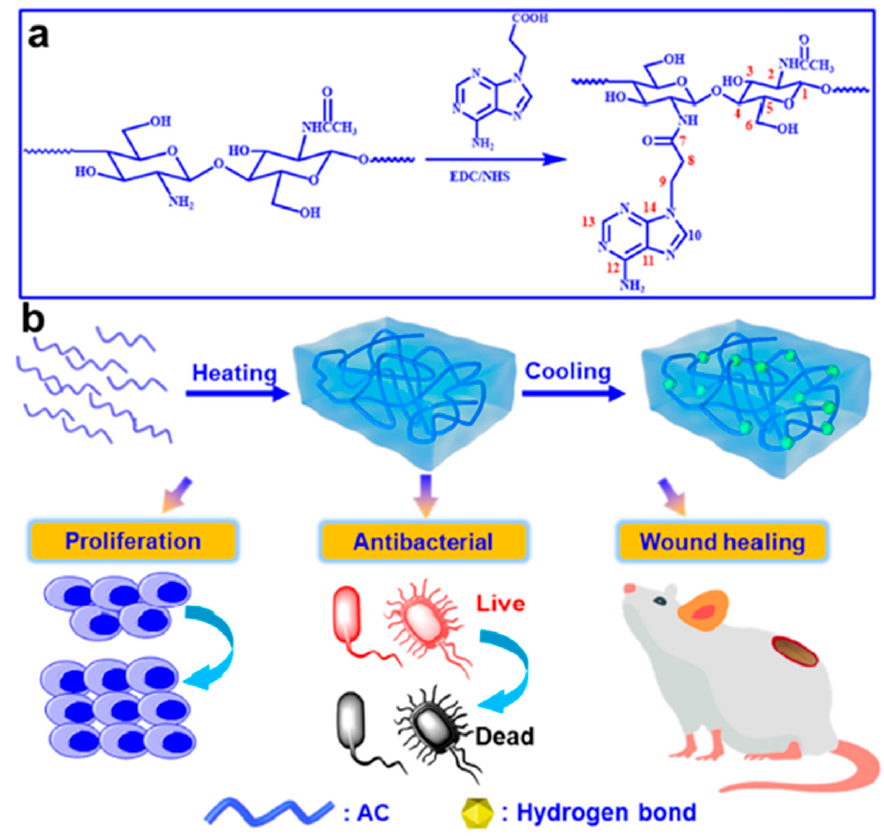
Figure 8. ( a ) The synthetic route of AC derivatives. ( b ) Schematic diagram of AC hydrogel preparation and promotion of wound healing, adopted from [37] with permission from Elsevier through copyright clearance center. AC: Adenine-modified Chitosan.